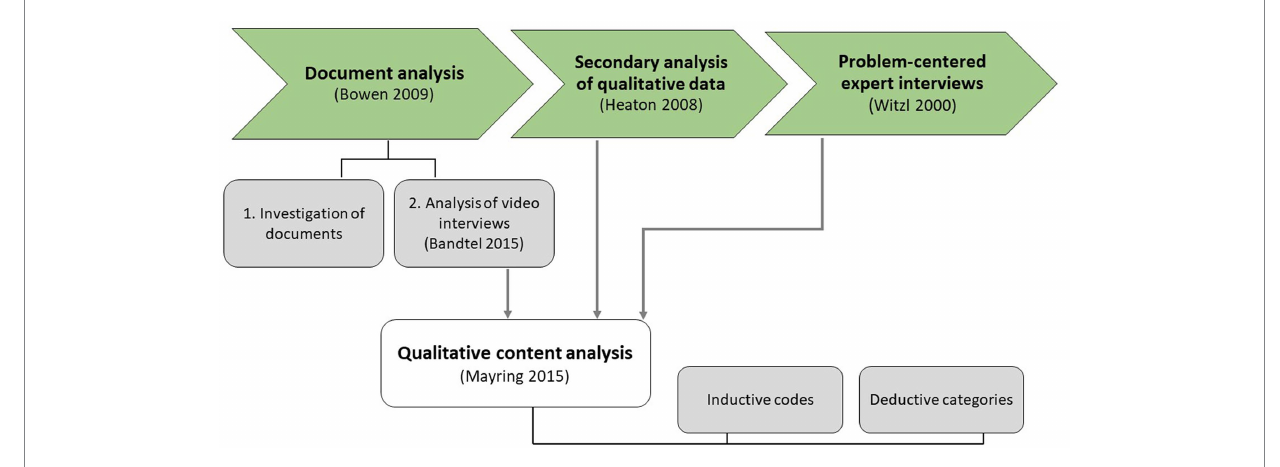
FIGURE 5 Methodological approach, created by the